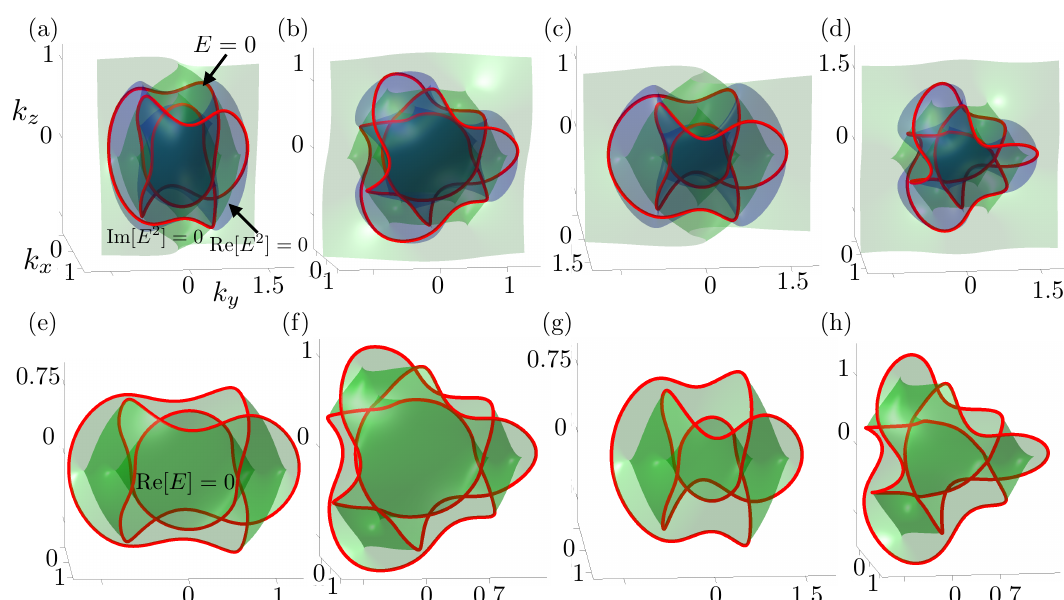
Figure 1: Illustration of hyperbolic exceptional structures, formed as the intersection between the two implicitly defined surfaces Re [ E 2 ] = 0 and Im [ E 2 ] = 0. The upper panel (a)-(d) shows this intersection explicitly, where (a) and (b) are continuum models with ε 2 = 1 and Λ = 100, and (c) and (d) are lattice models with ε 2 = 0.5 and Λ = 100. The lower panel (e)-(h) shows the exceptional structures along with their corresponding Fermi surface. (a) and (c) are figure-eight knots in continuum and lattice models respectively, while (b) and (d) are Borromean rings. The topologies of the nodal structures are determined by calculating the Alexander polynomial for all components. In the case of links, the linking number and, if necessary, higher-order Milnor invariants are also